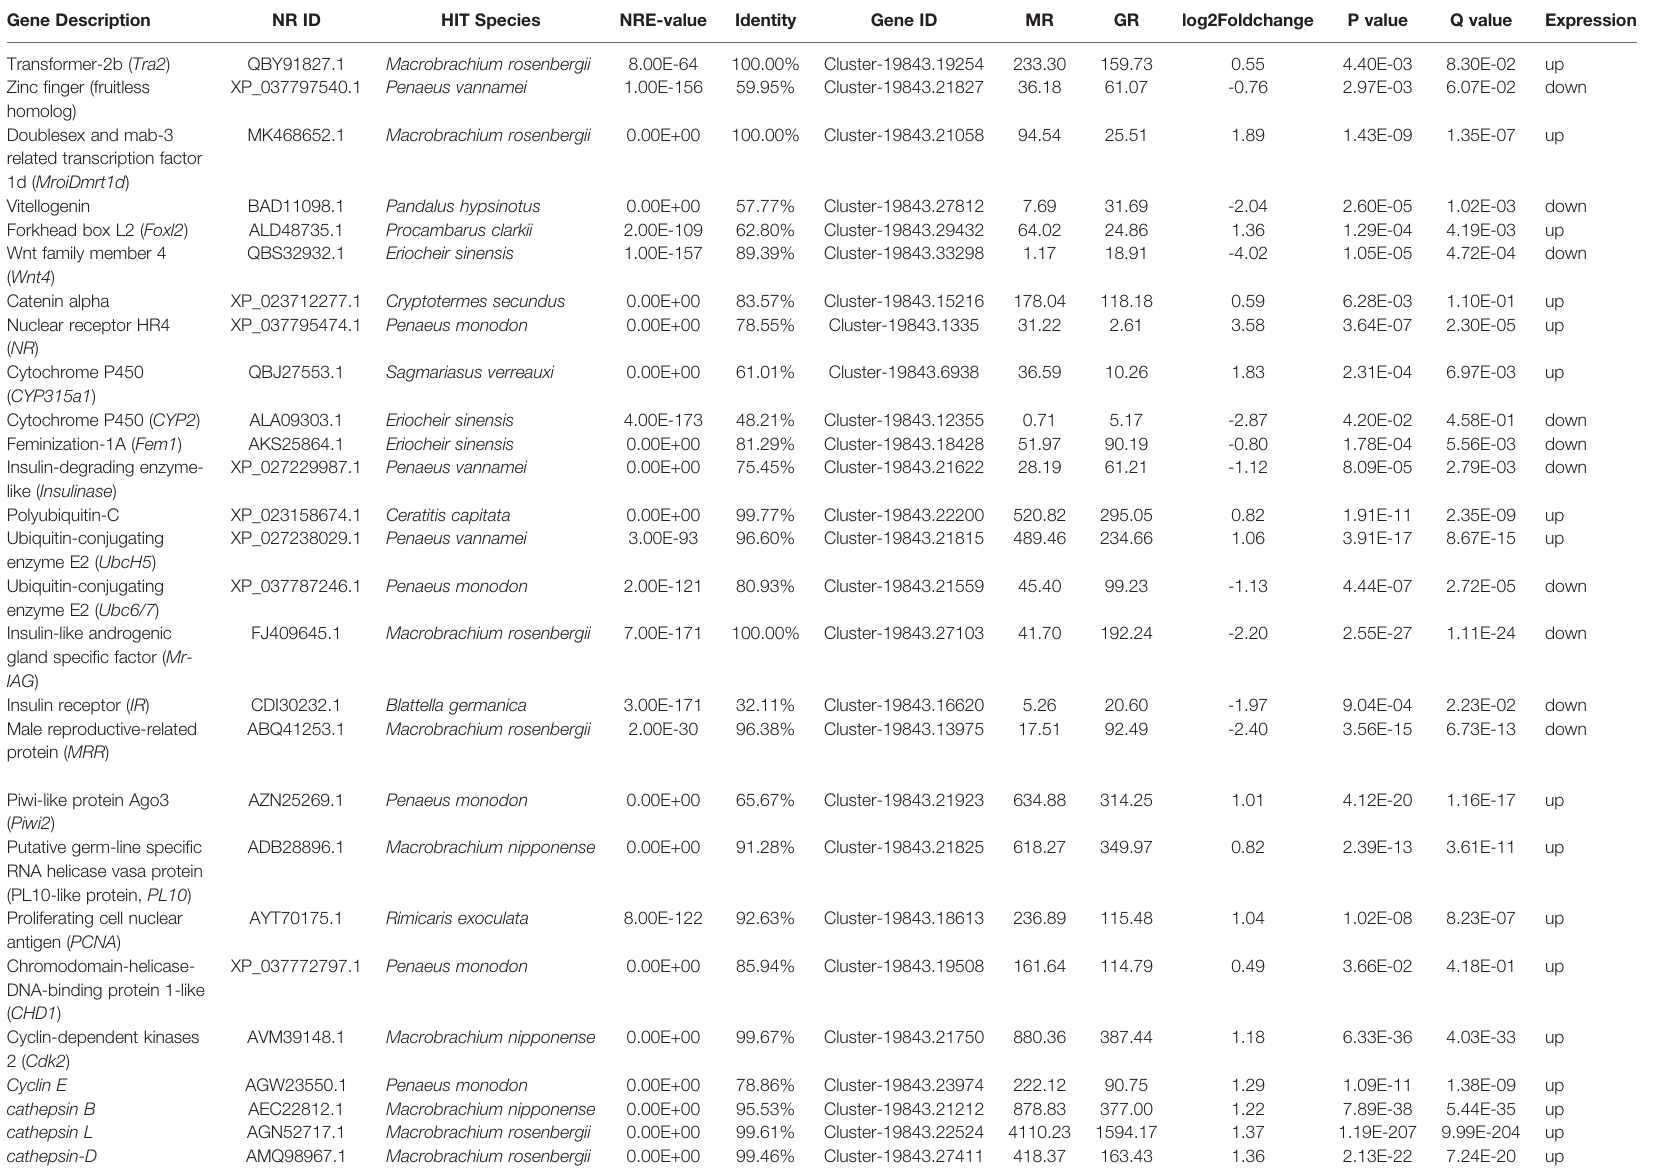
TABLE 2 | Signi fi cantly differential expression of sex-related candidate genes in sexual differentiation and gonad development. Gene